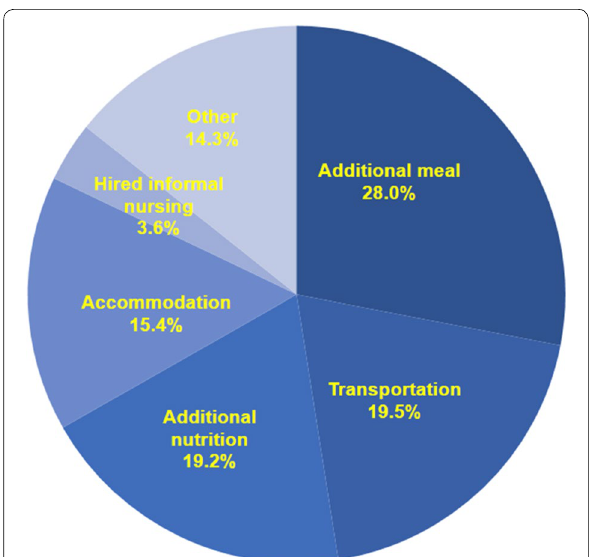
Fig. 2 Proportional breakdown of non‑medical expenditures for diagnosis and treatment of colorectal